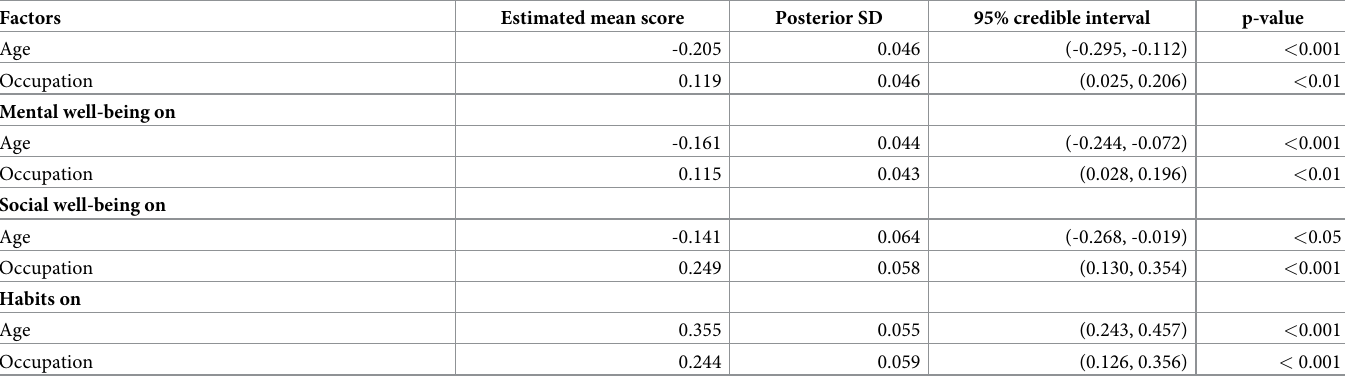
gence. The trace plots for selected parameters demonstrates that a tight horizontal band which indicates the parameters are converged (Fig 2). The posterior probability density plots that indicate the posterior densities for these parameters are approximating normal density (Fig 3).